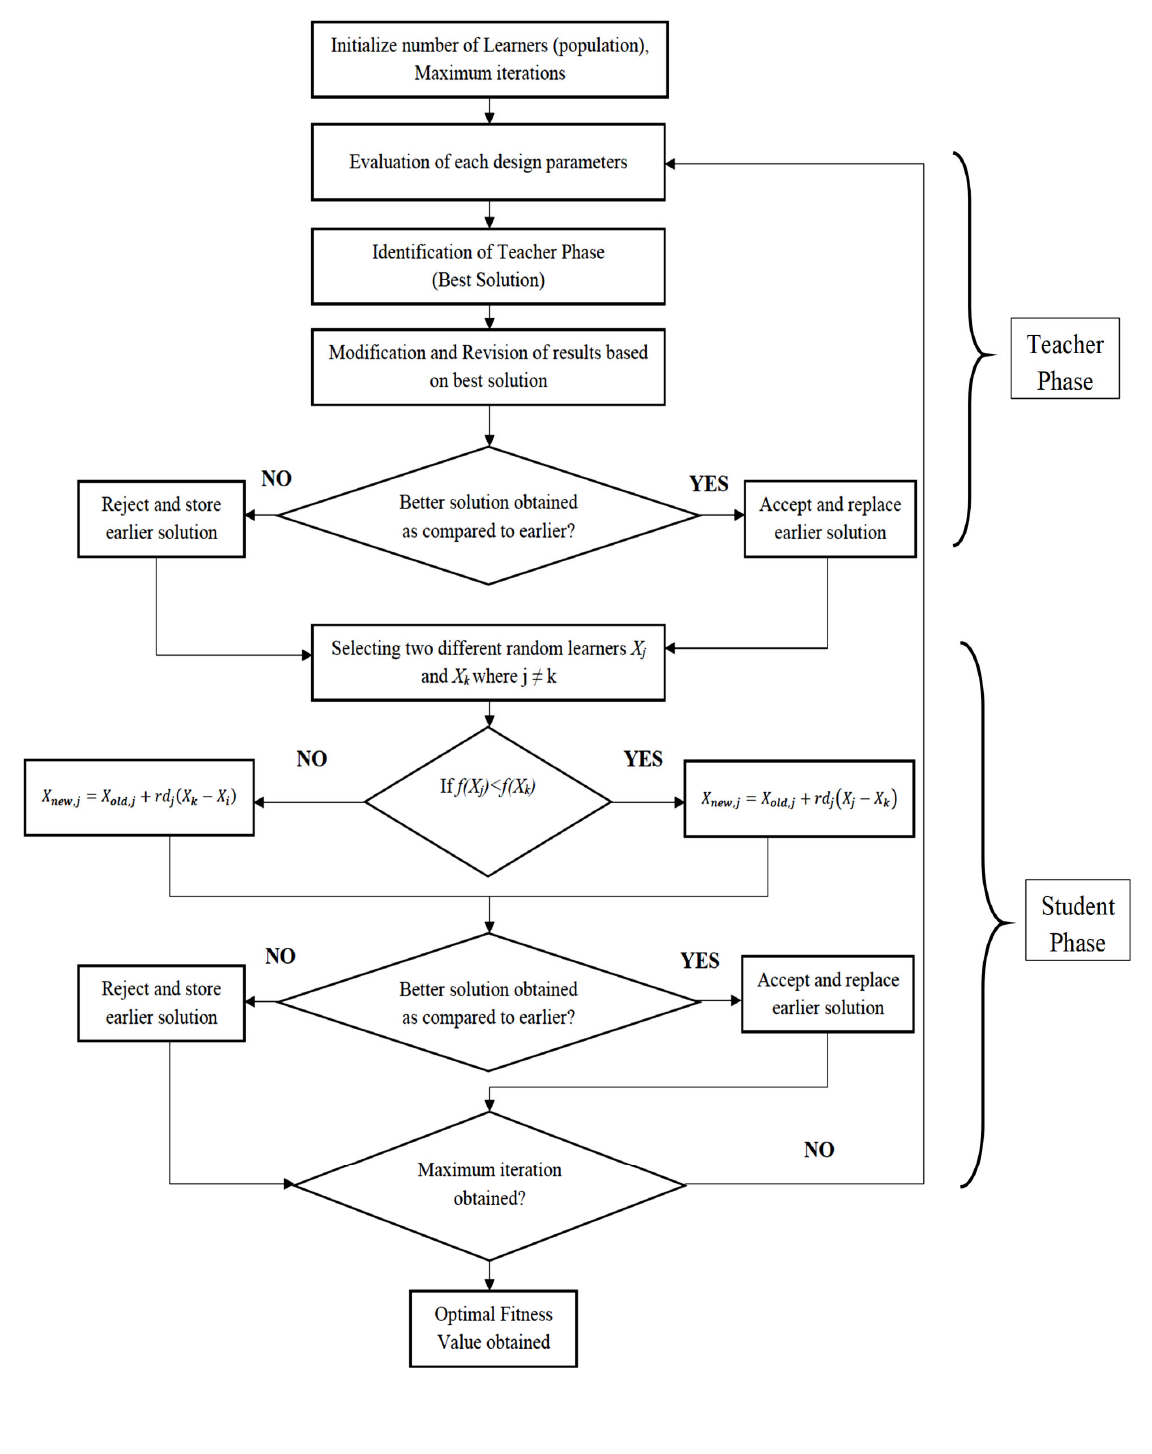
Fig.4. TLBO Flow-Chart (R. V. Rao et al.,